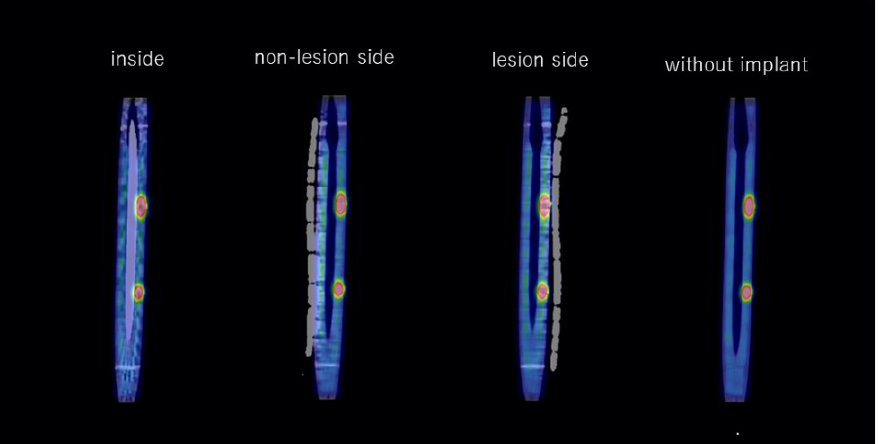
Figure 4. Fused coronal images (SPECT and CT) with and without the implant.